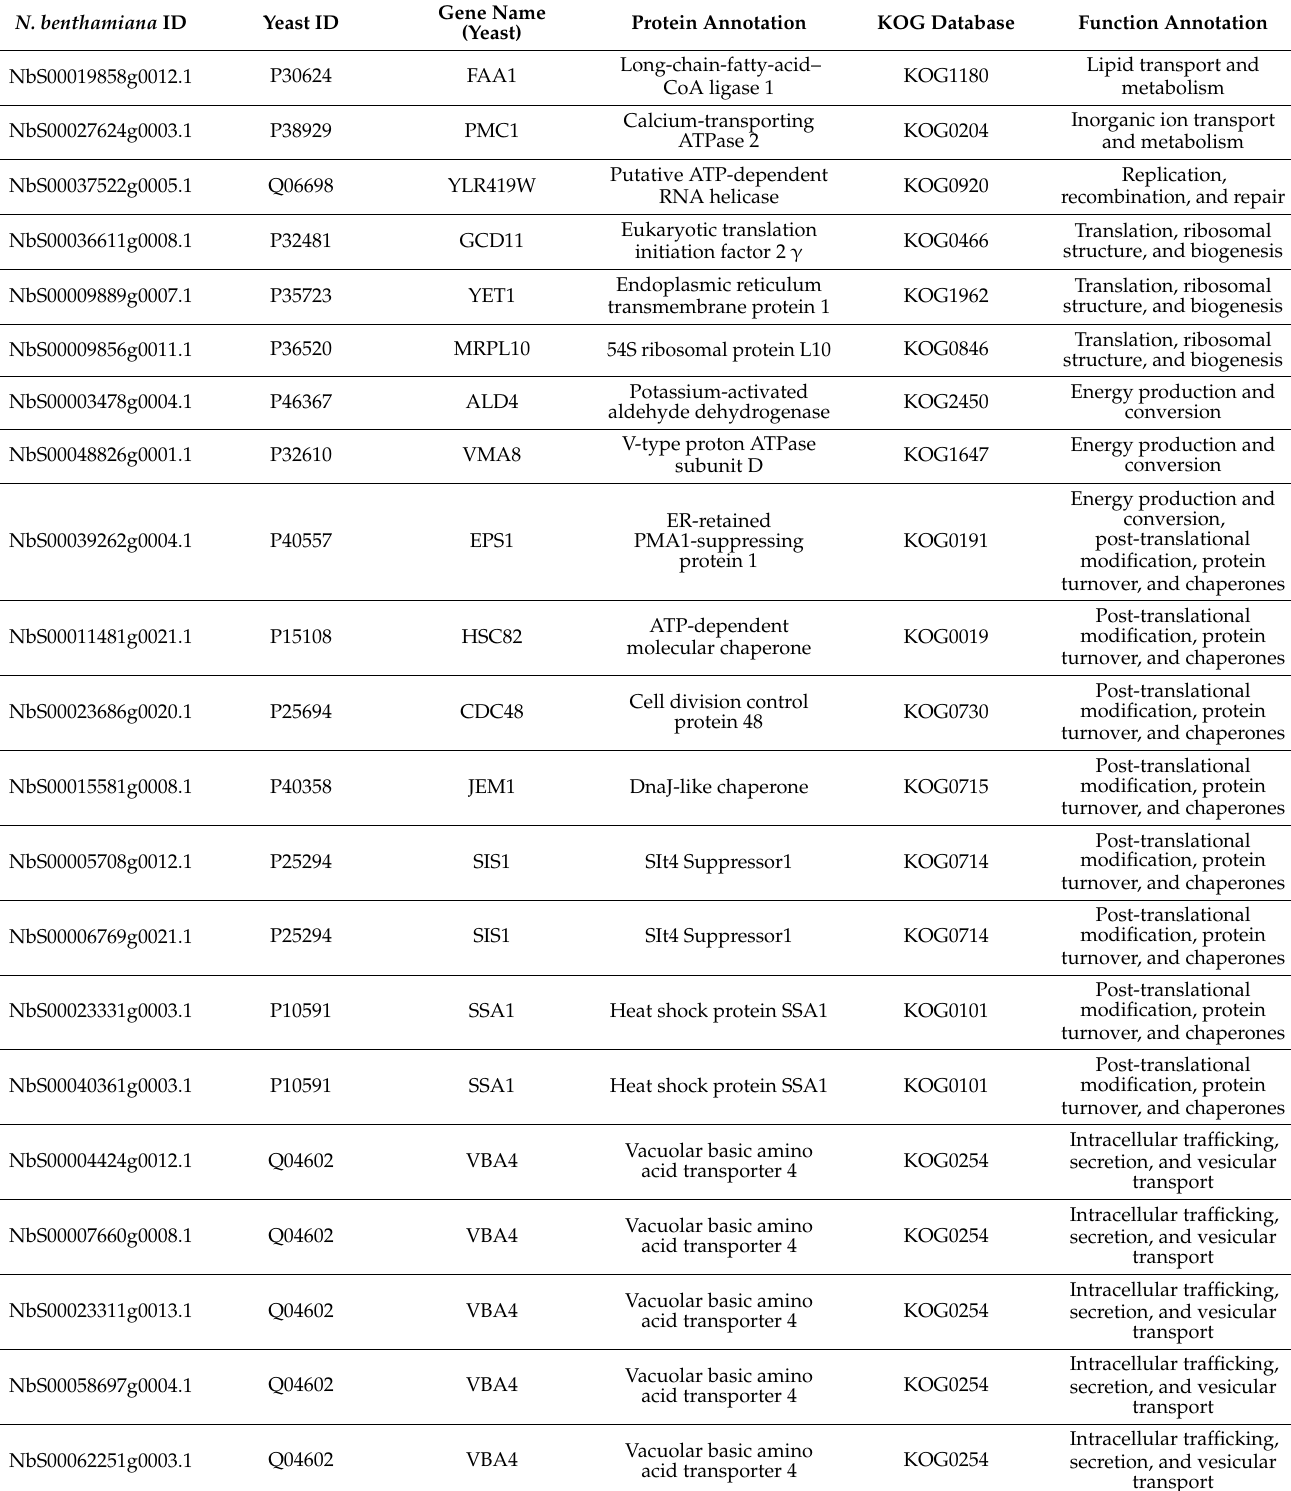
Table 2. Overlap in functional annotations of proteins present in the RNP containing fraction of N. benthamiana and yeast. N. benthamiana